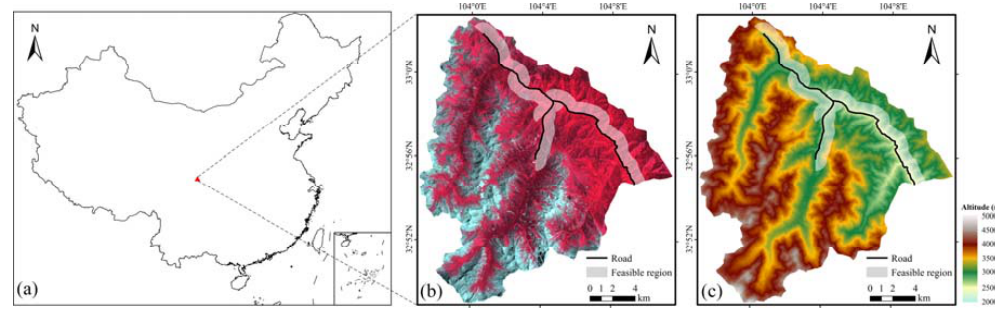
Figure 1. ( a ) Map of China with the location of Wanglang experimental site. ( b ) A Landsat 8 Operational Land Imager (OLI) image and ( c ) an elevation map of the study area. The roads and the feasible accessible region are shown.